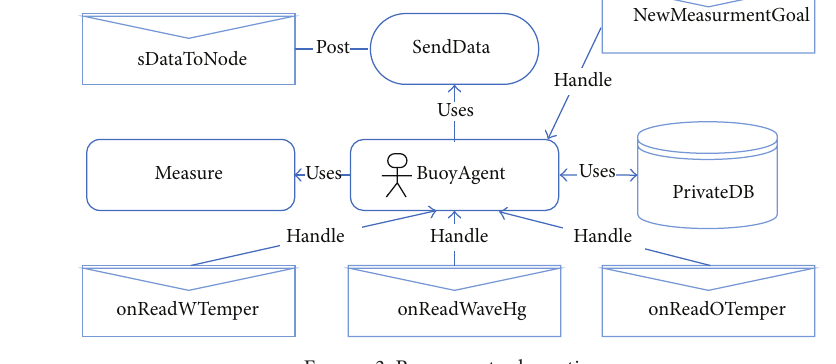
Figure 3: Buoy agent schematic.